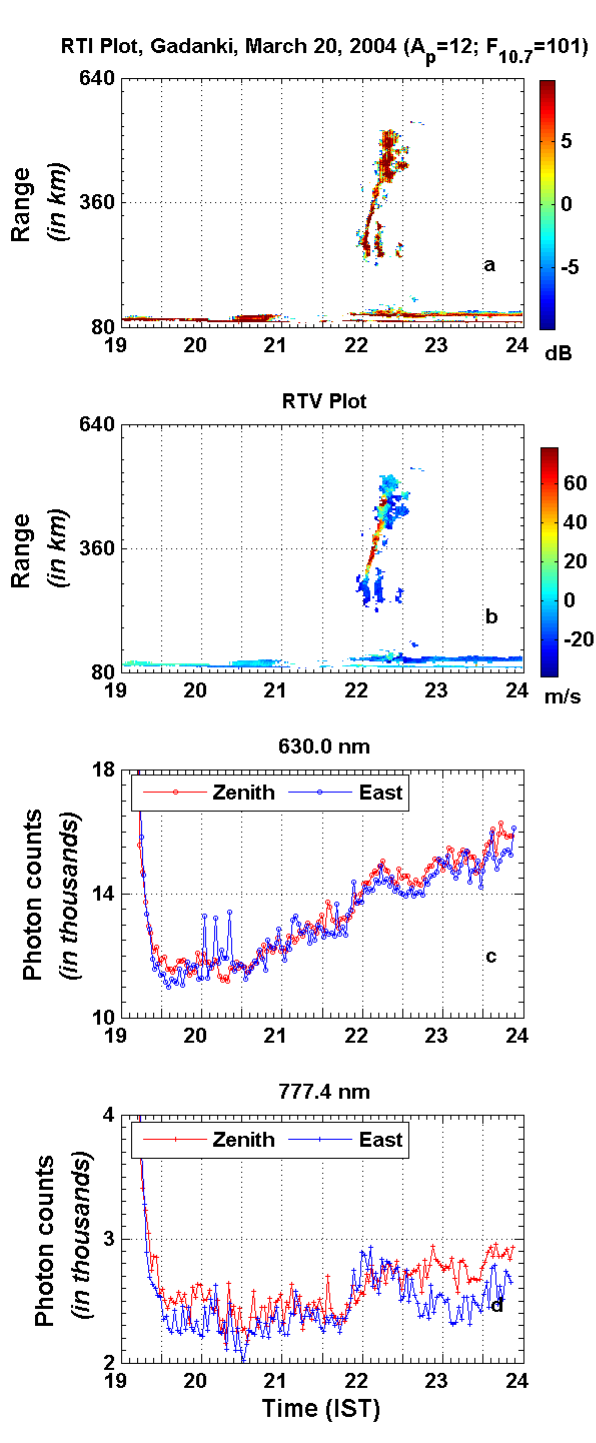
Fig. 8. Similar to Fig. 7 but for 20 March 2004 revealing isolated plasma plume